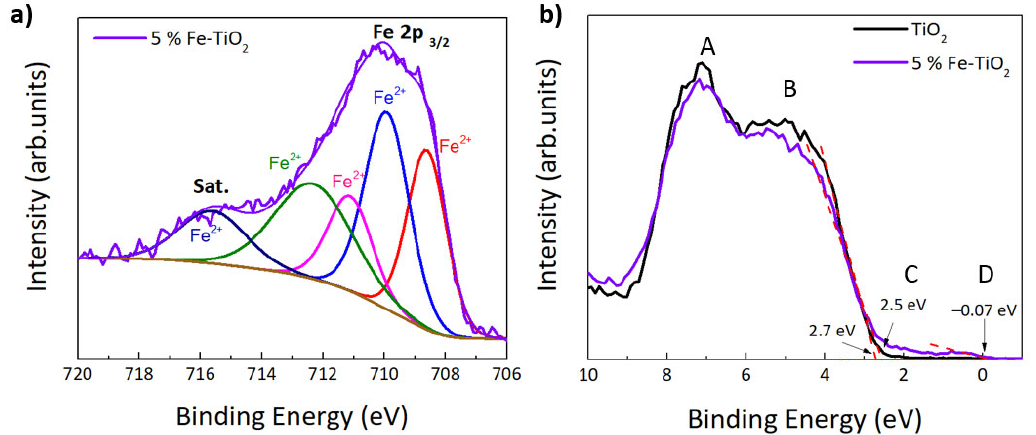
Figure 6. ( a ) XPS spectrum of Fe 2p for 5 mol % of Fe ‐ TiO 2 with PEG (in which red, blue, pink, green and dark blue colors represent the Gaussian–Lorentzian components that best fitted Fe 2p spectrum (GL 30)), and ( b ) valence band (VB) XPS spectra of pure TiO 2 and Fe-TiO 2 with (GL 30)), and ( b ) valence band (VB) XPS spectra of pure TiO 2 and Fe ‐ TiO 2 with PEG.